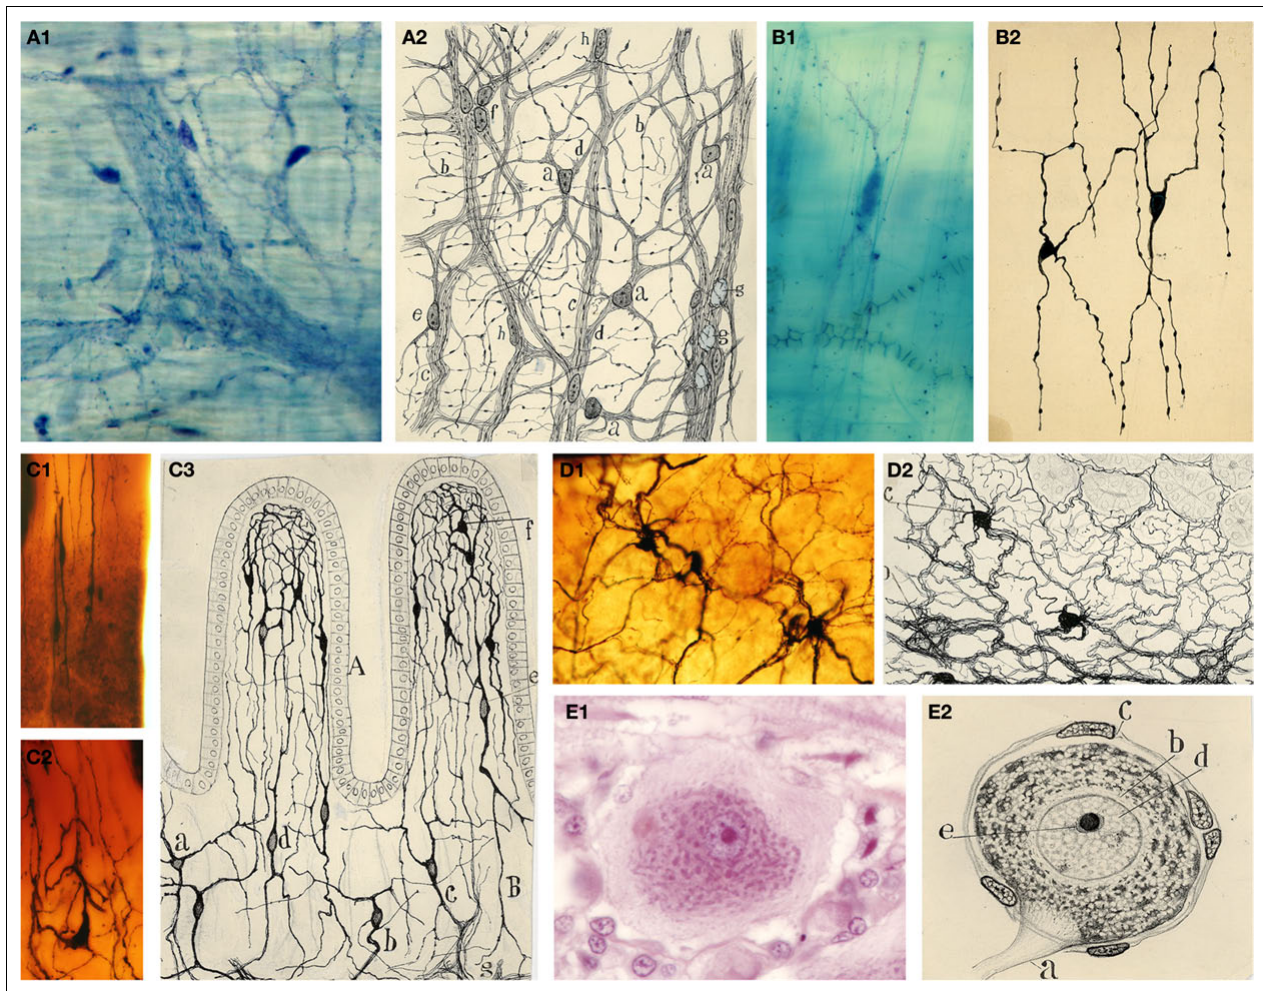
FIGURE 8 | Cajal’s histological preparations and drawings showing some contributions to the peripheral nervous system. (A) Auerbach plexus and interstitial Cajal’s cells of a frog (methylene blue method); (B) Interstitial Cajal’s cells